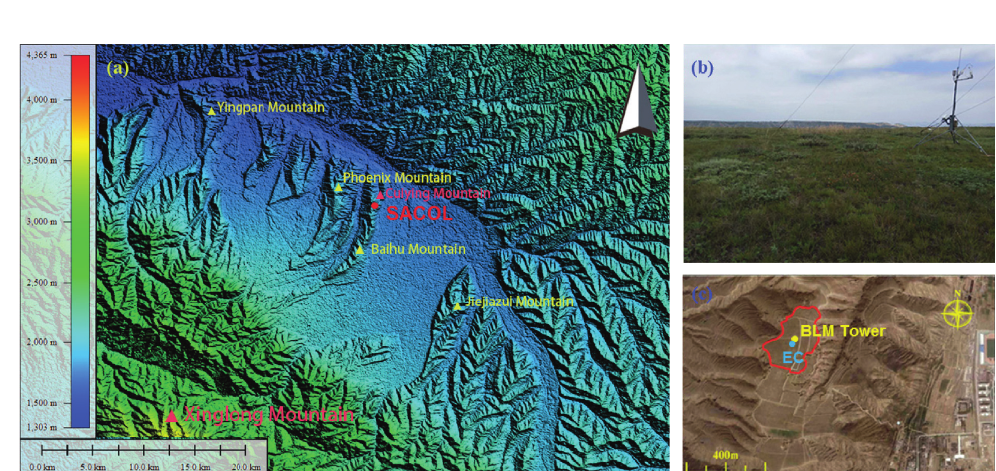
Figure 1: (a) Topographic map of the Semi-Arid Climate and Environment Observatory of Lanzhou University (SACOL), (b) vegetation of the flux observation field in summer, and (c) area surrounding the observation field obtained from Google Earth. The area surrounded by the red line is the observation field, and yellow and blue circles represent the locations of the boundary layer meteorological tower (BLM tower) and the eddy covariance (EC) system. The figure is from Liang et al. [18], and the topographic map in Figure 1(a) is drawn using ASTER GDEM v2 data